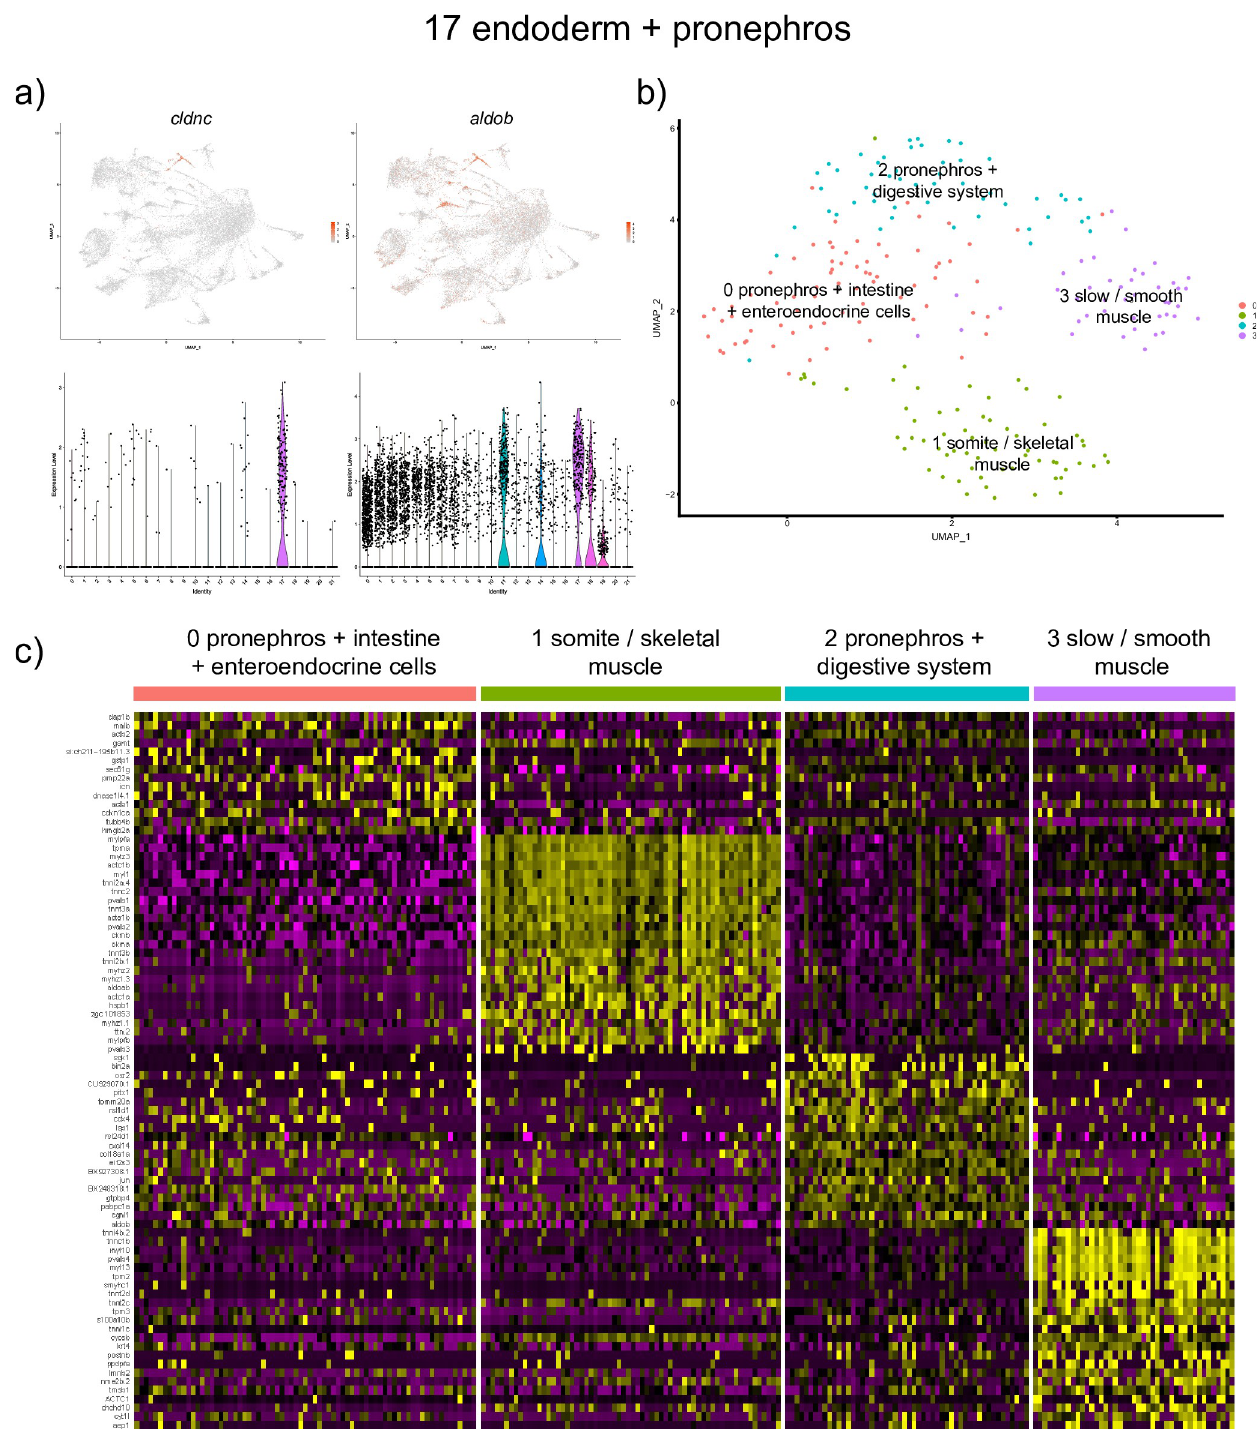
Fig 6. Analysis of the endodermal and pronephros cluster #17. (a) UMAP and violin plots showing the expression of top marker genes, cldnc and aldob . (b) UMAP plot showing further subclustering of this group that resulted in 4 cell subclusters. (c) A heatmap showing expression of marker genes in the subclusters. Note that muscle subclusters #1 and 3 are also positive for endodermal/pronephros marker expression.